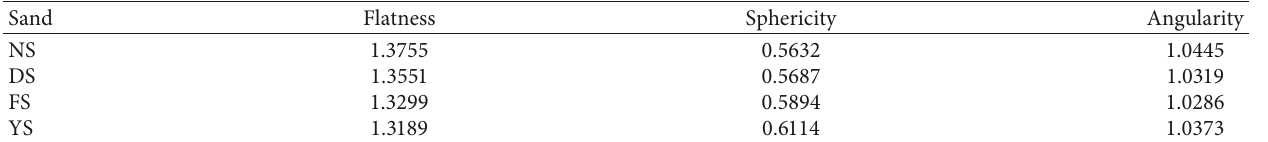
Figure 2: Microscope image and binarized image. Table 3: Shape parameters of the types of source sand.